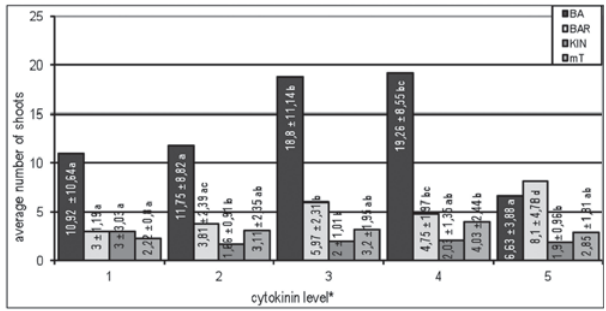
Figure 4. Number of shoots of in vitro Nidularium ’Kertész Jubileum’ plants cultured on different kind of medium (*cytokinin levels were shown on Table 1 )